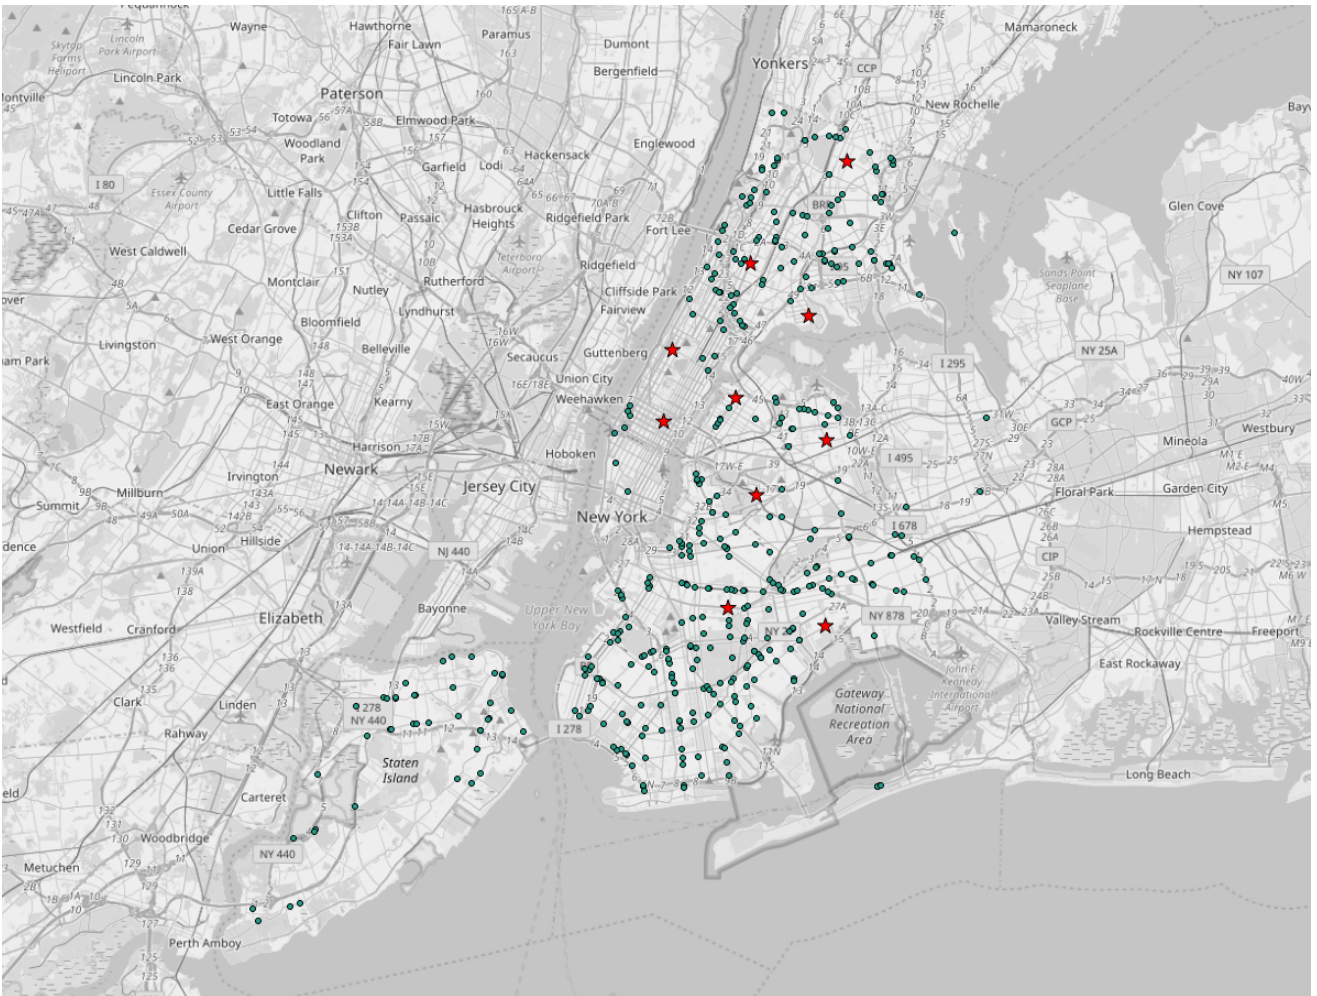
Figure 6. NYC gas stations and candidate